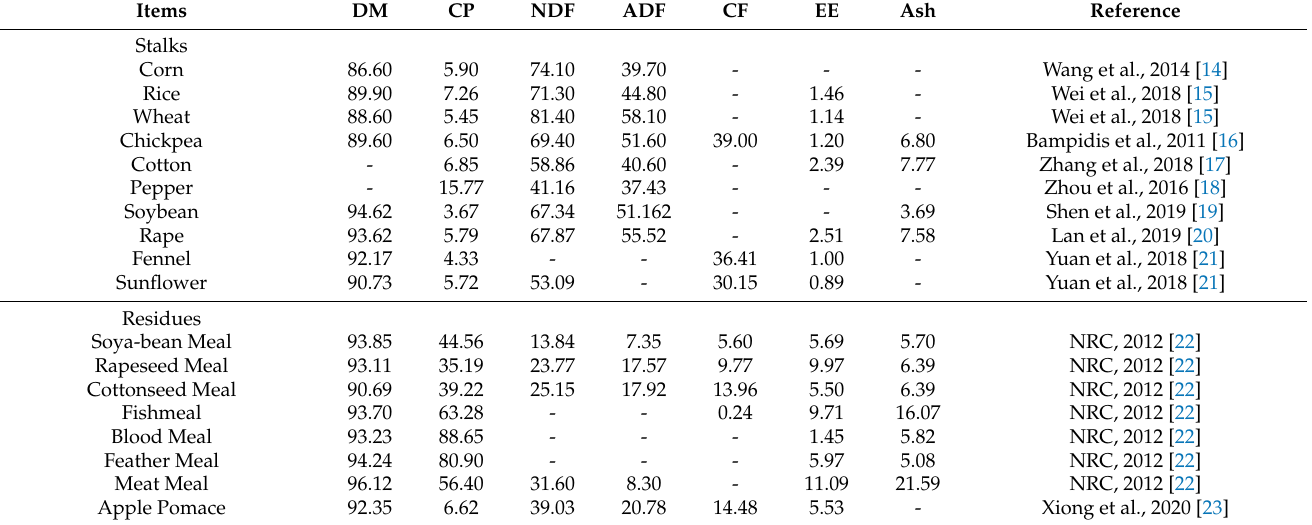
Table 1. The chemical composition of straws and residues from food (%).